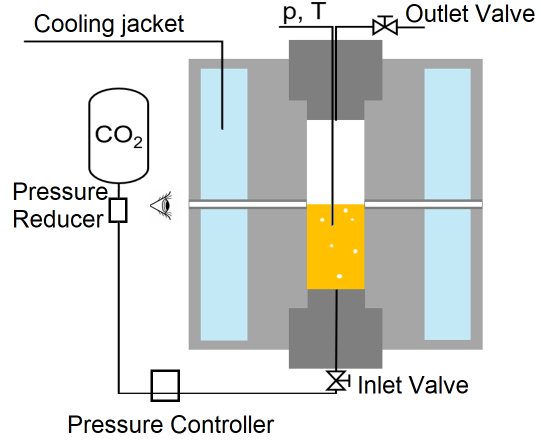
Figure 1. Schematic of the used bubble column